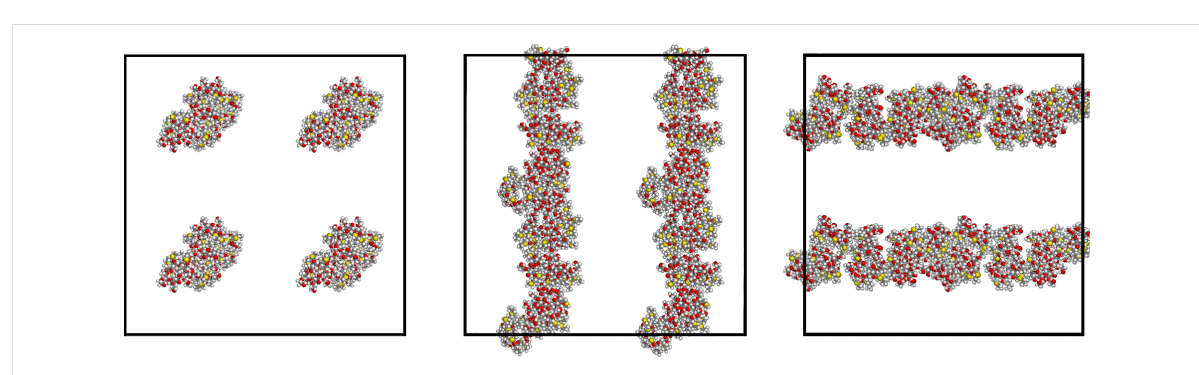
Figure 4: The second trial starting arrangement of sixty-four molecules within the large cell of 123.0 Å, symmetrically arranged in four parallel arrays along the z -axis of the projections, and each comprising twice the eight molecules of Figure 2 as obtained in the previous run with the smaller cell of 61.5 Å. The three projections are taken along the cell z -axis, the y -axis, and the x -axis from left to